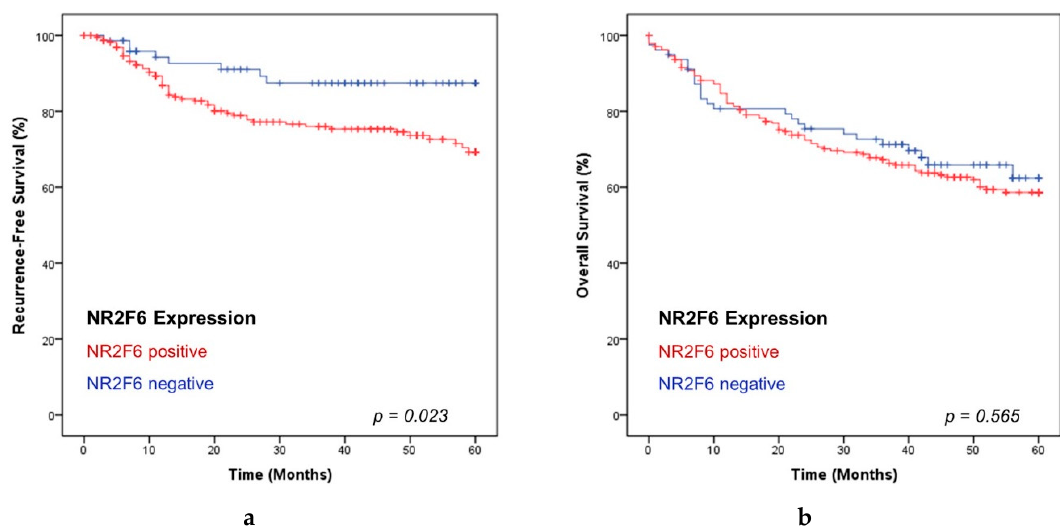
Figure 6. Kaplan Meier analyses of NR2F6 positive and negative HNSCC. ( a ) NR2F6 positive HNSCCs correlated with a significantly lower rate in RFS ( p = 0.023). ( b ) There was no significant difference in the OS rates between NR2F6 positive and negative tumors ( p = 0.565).